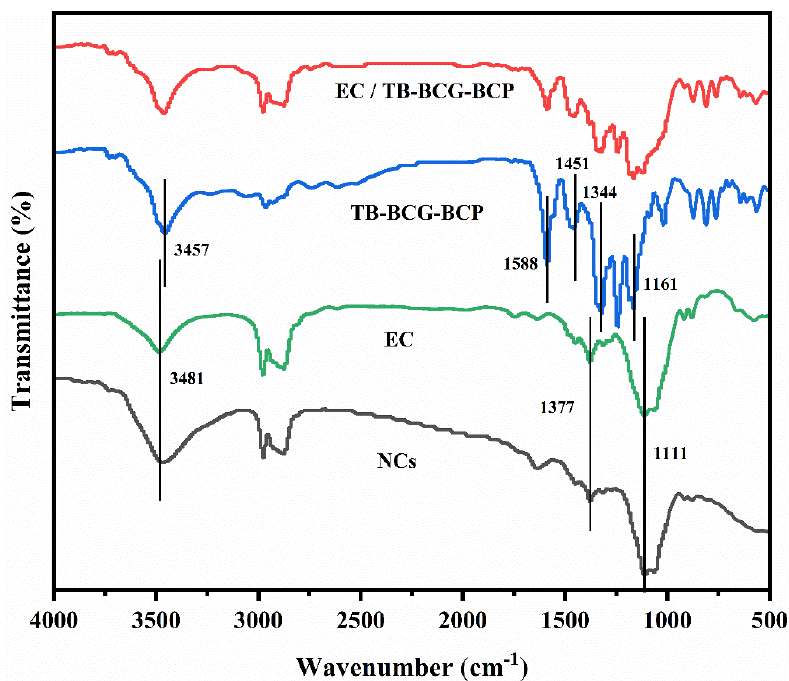
Figure 3. FTIR spectra of pure TB-BCG-BCP, EC, an EC/TB-BCG-BCP mixture, and nanocapsules loaded with TB-BCG-BCP.